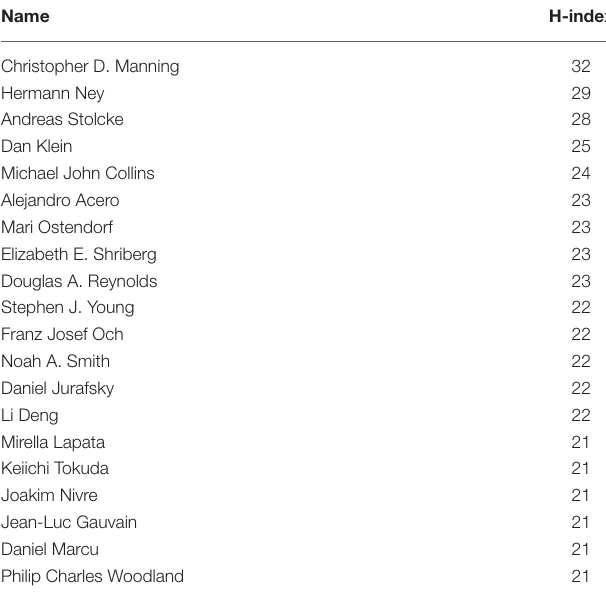
TABLE 12 | List of the 20 authors with the largest h-index.